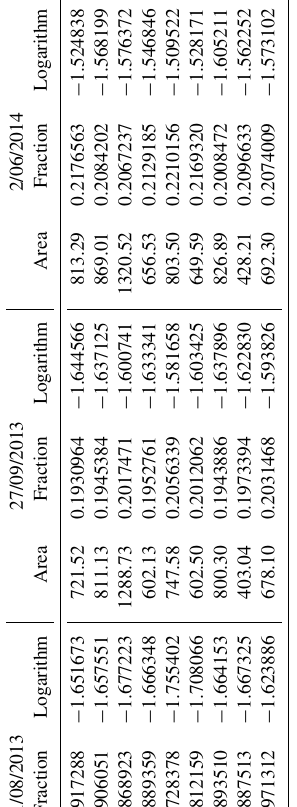
Figure 6. Hydrographs recorded in Gorzuchów before (approx. 5 days) and after (approx. 2 days) UAV flights on (a) 27 Novem- ber 2012, (b) 13 May 2013, (c) 21 August 2013, (d) 27 Septem- ber 2013 and (e) 2 June 2014.